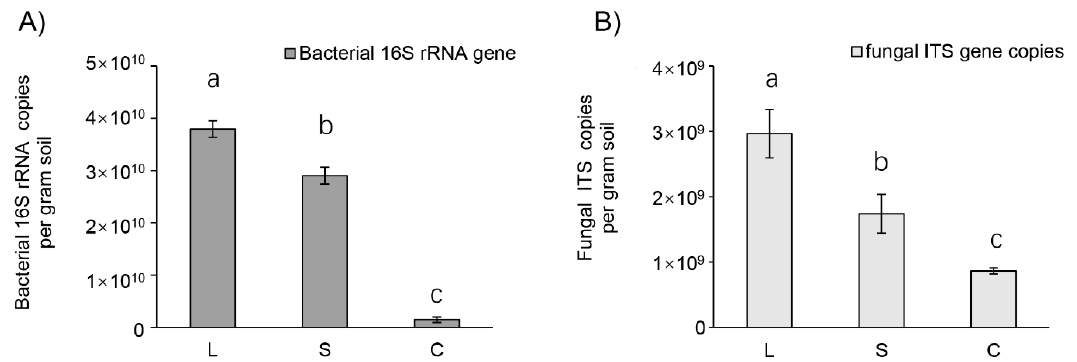
Figure 6. Microbial gene copy numbers in mushroom cultivation soils determined by qPCR. Values are given by primers targeting ( A ) bacterial 16S rRNA and ( B ) fungal ITS region in three different Stropharia rugosoannulata cultivation areas with various influencing intensities: C = control forest soil with no influence from mushroom cultivation; L = soil from furrows with low influence by mushroom cultivation; S = soil below fungal beds strongly influenced by mushroom cultivation. Different lowercase letters for bacterial or fungal gene copy numbers indicate significant differences ( p < 0.05, ANOVA, Tukey HSD) of bacterial and fungal gene copies.